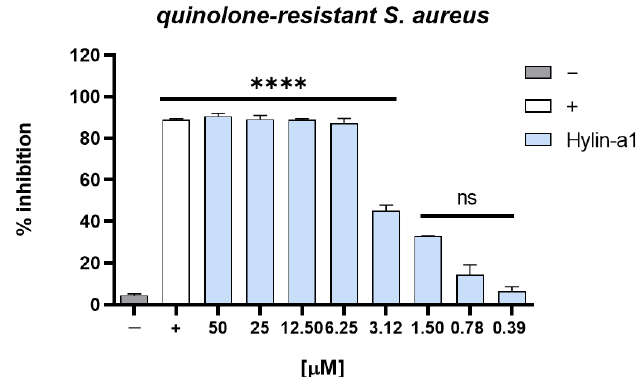
Figure 3. Antibacterial activity against S. aureus strains. A microdilution assay was performed to evaluate the activity against multi-sensitive ( A ), macrolide-resistant ( B ), methicillin-resistant ( C ), β- lactamase resistant ( D ) and quinolone-resistant S. aureus ( E ). The peptide was tested at different concentrations ranging from 50 to 0.39 μM. As a positive control (+), vancomycin was used (6.9 μ M), while bacterial medium represented the negative control (−). **** p < 0.0001; ns: non-significant. Hylin-a1 strongly inhibited macrolide-resistant and quinolone resistant strains very similarly to what observed for the multi-sensitive strain (Figure 3A,B,E), retaining the same MIC (6.25 μM) previously observed with the ATCC strain (Figure 2).